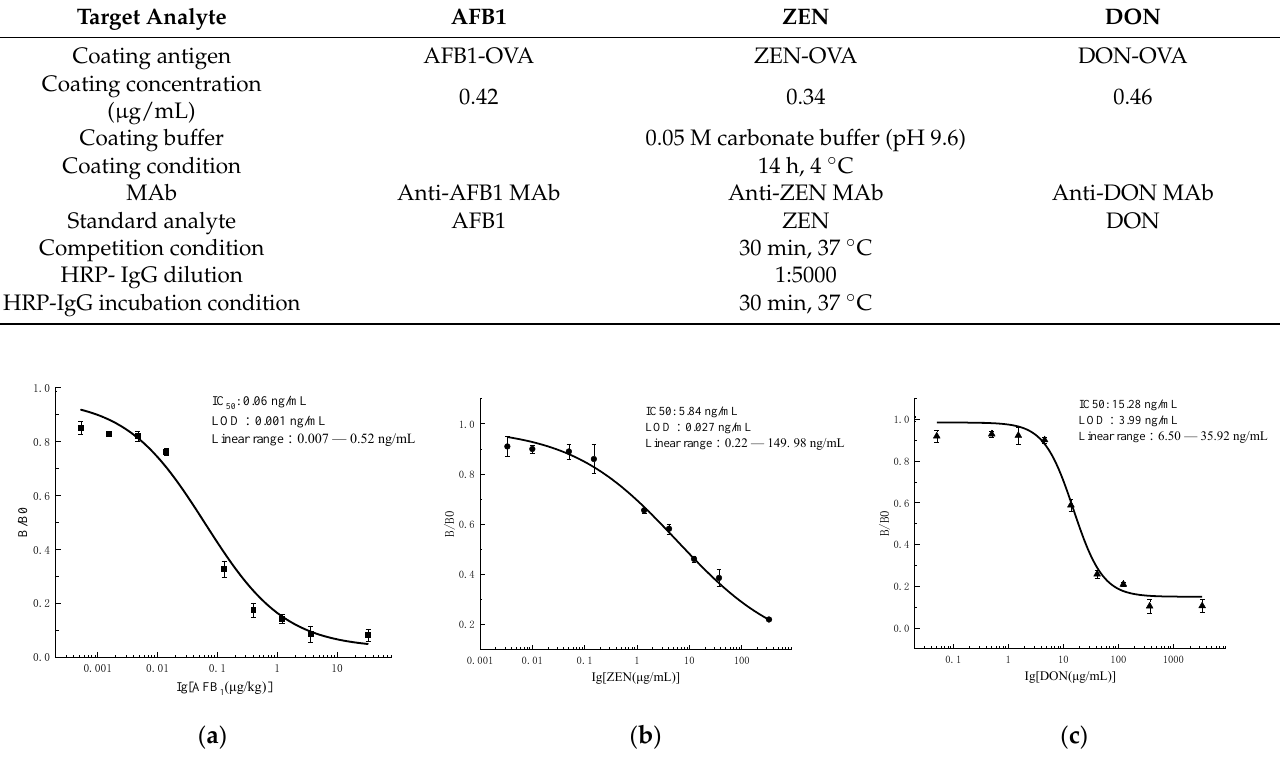
Table 2. Indirect competitive ELISA for AFB1/ZEN/DON monoclonal antibodies.